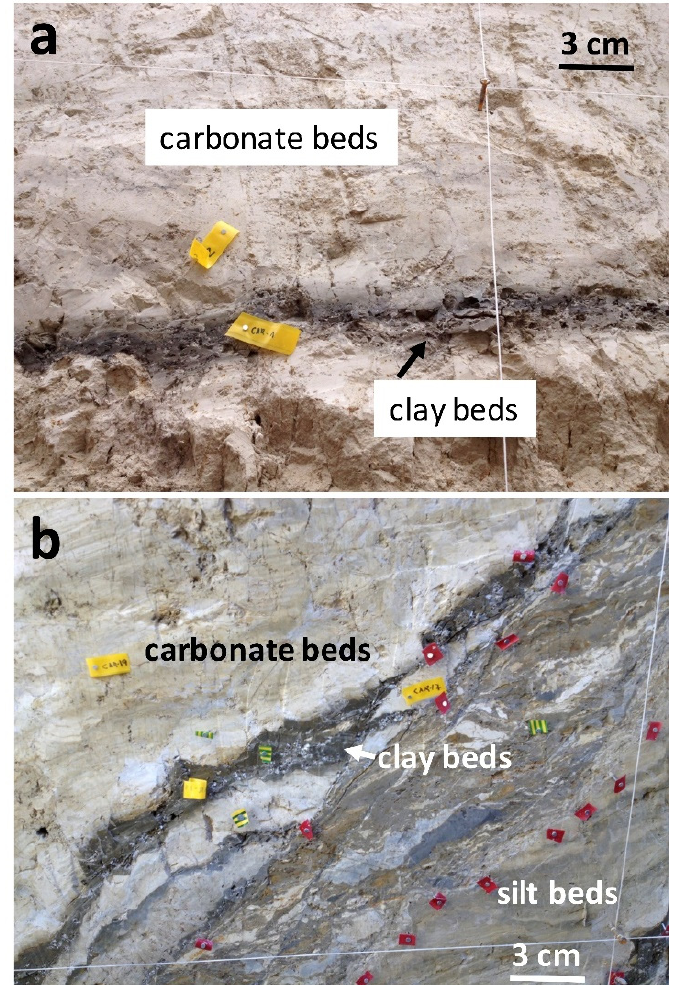
Figure 3. ( a , b ) Pictures of the materials exposed in the Carrizal trench. Carbonate beds appear as thick white layers. Silt beds occur as disrupted brown and grey layers. Clay beds develop thin, dark grey linear laminations.